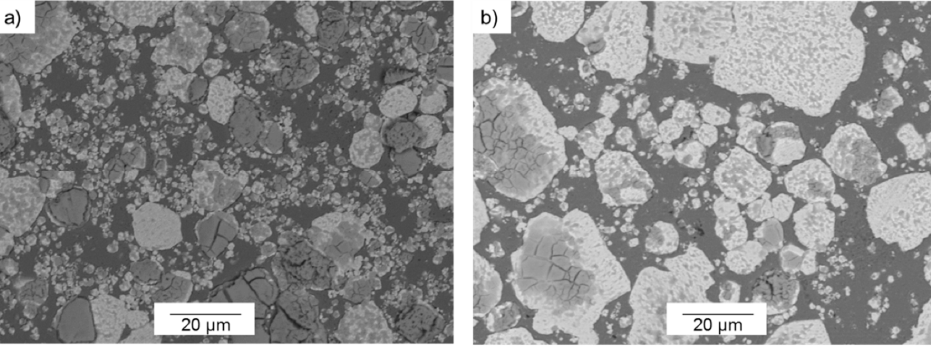
Figure 6. ( a ) Back Scattered Electron-SEM image of 75-W/25-Cu alloy prepared from bimodal powder 30-W f :70-W c , degasification time 5 s, and hot consolidation time 90 s; ( b ) Back Scattered Electron-SEM image of 75-W/25-Cu alloy prepared from bimodal powder 10-W f :90-W c , degasification time 10 s and hot consolidation time 90 s.